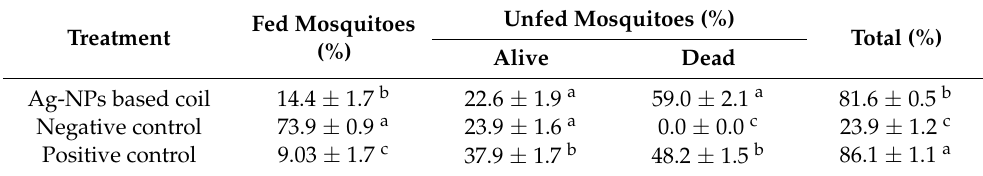
Table 3. Smoke toxicity of mycosynthesized Ag-NPs-based coils against the adults of A. aegypti . Fed Treatment